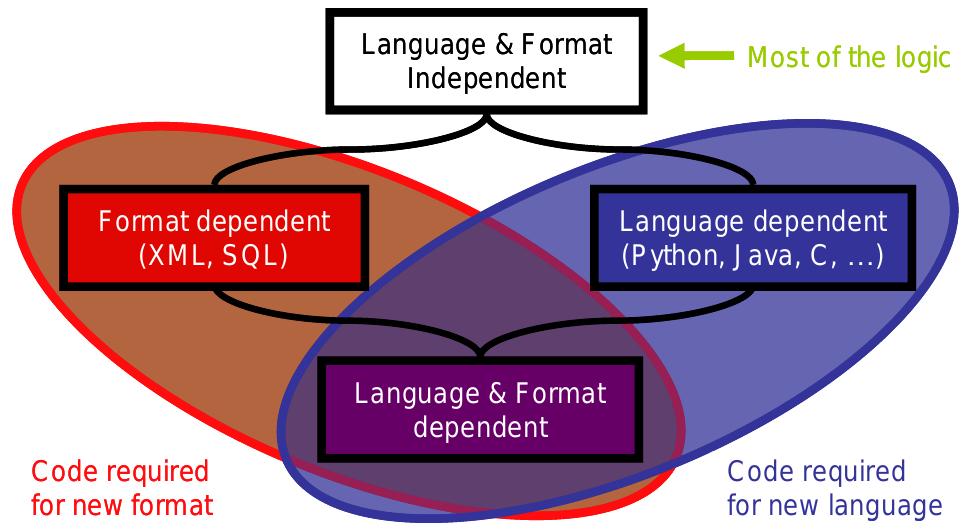
Supplementary Figure 2: Organisation of API generator code. Many tasks are independent of the language or storage implementation being generated. By separating out the code, common actions need only be coded once, and new implementations can be added with minimum